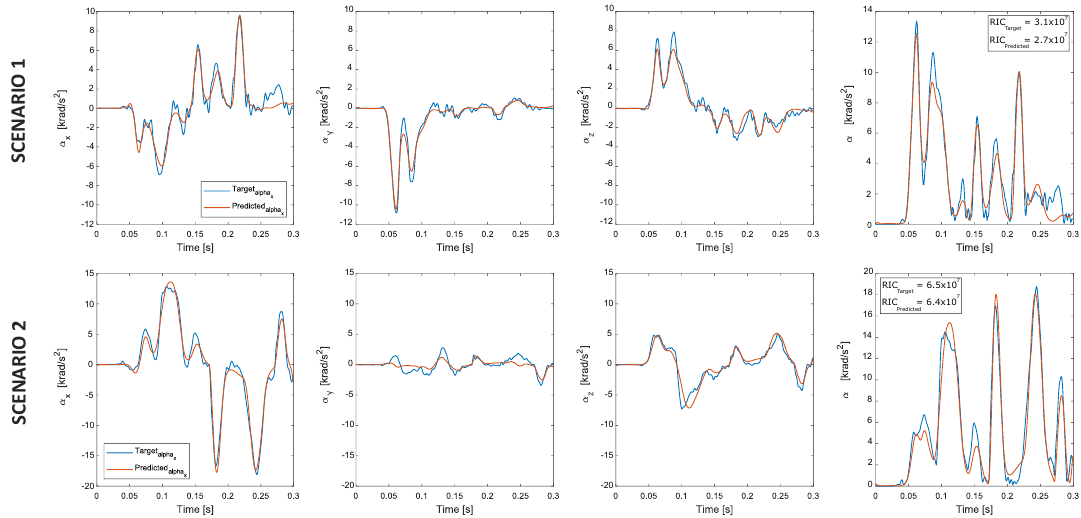
Figure 8. Rotational acceleration prediction using the deep neural network model.